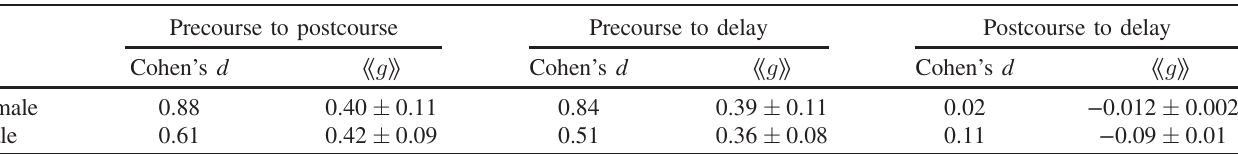
TABLE II. Two measures of the effect of instructions, Cohen ’ s d and normalized learning gain ⟪ g ⟫ , disaggregated by gender. Precourse and postcourse as well as precourse and delay comparisons were statistically significant for both females and males ( p < 0 . 001 ). Postcourse and delay showed no statistically significant difference but are included here for